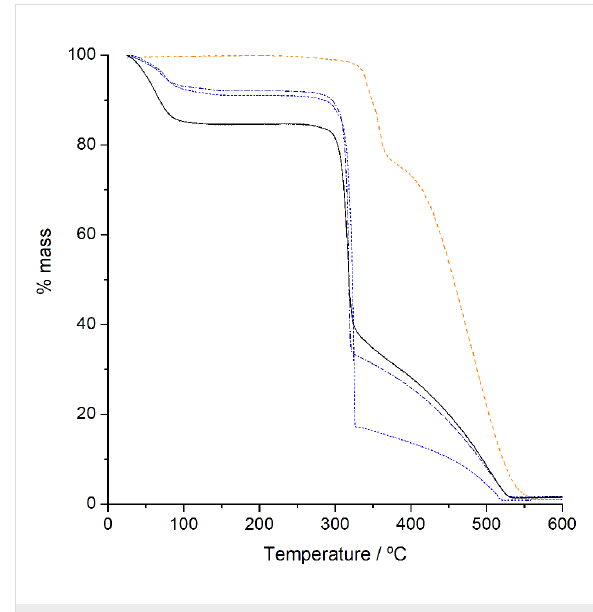
Figure 3: TG traces for fisetin (orange dashed line), γ -CD (blue dotted line), their 1:1 physical mixture (black dashed dotted line), and γ -CD·fisetin (black solid line). The physical mixture was prepared by weighing equimolar amounts of γ -CD and fisetin and gently mixing the two powders with a